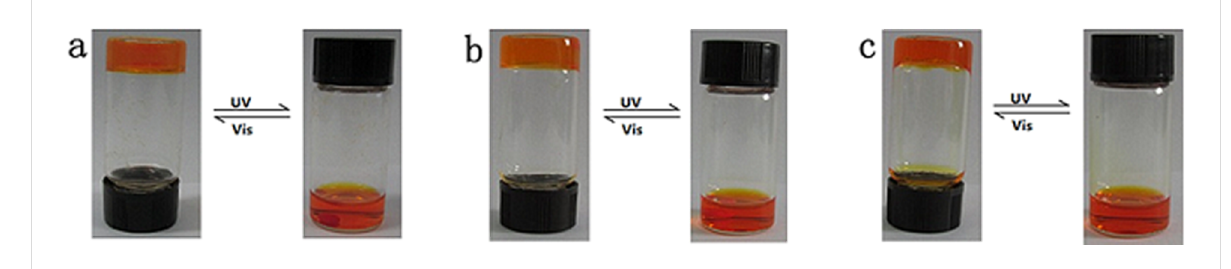
Figure 3: Photographic images of the M 6 sol-gel transition behavior after UV or visible light irradiation in different solution (a) ethanol, (b) isopropanol and (c) 1-butanol.